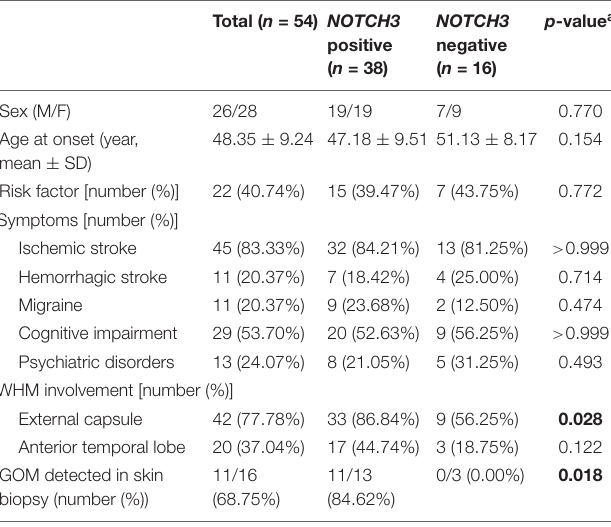
TABLE 1 | Summary of clinical features of 54 proband